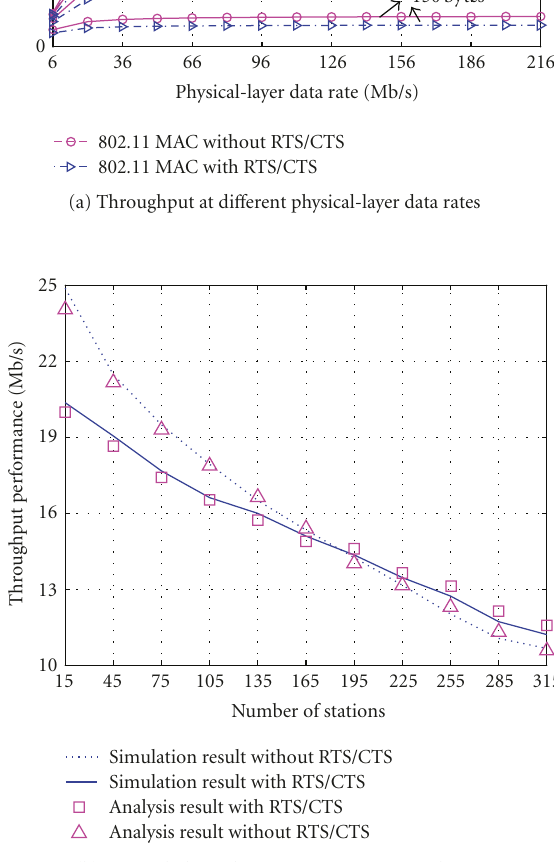
Figure 1: Legacy MAC throughput at di ff erent user populations and physical-layer data